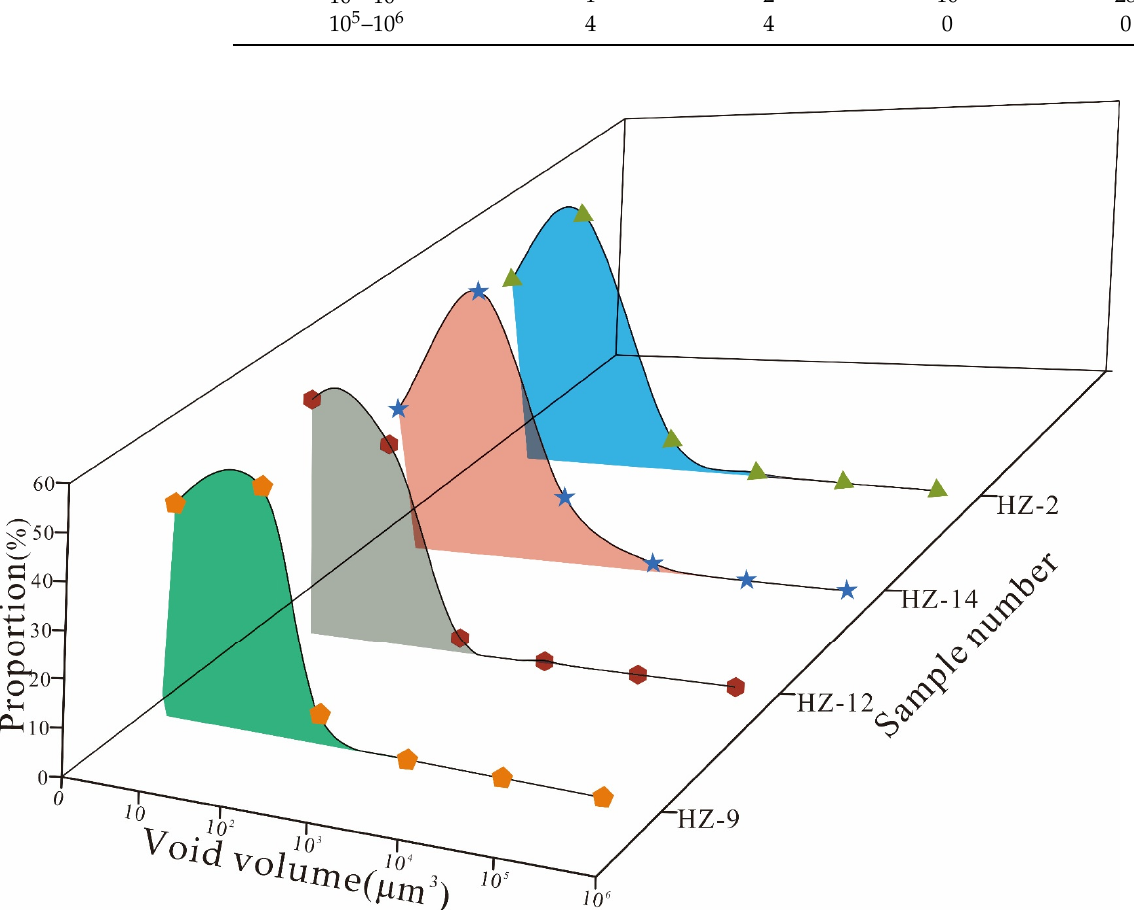
Figure 9. Pore volume ratio of the carbonate rock samples in the Huize lead–zinc deposit.